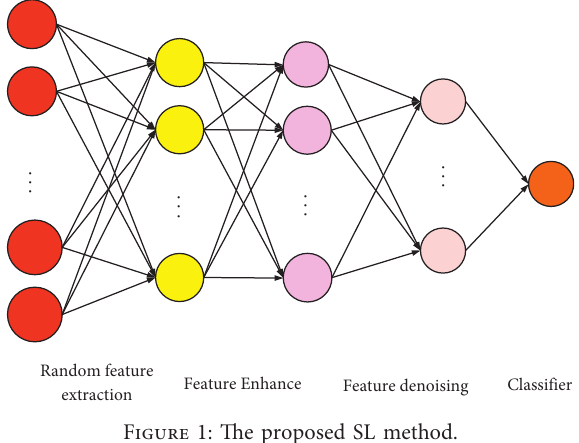
Figure 1: The proposed SL